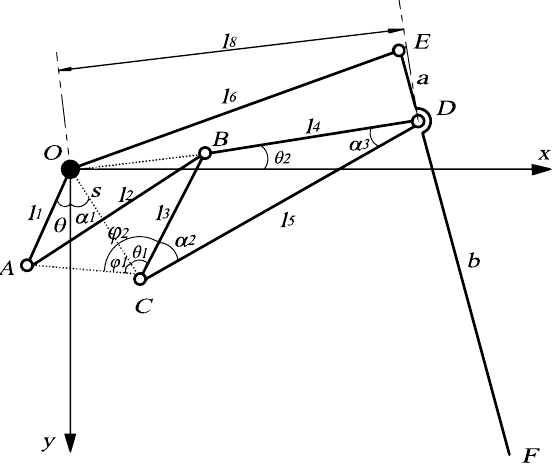
Figure 4. Schematic diagram of kinematics analysis.